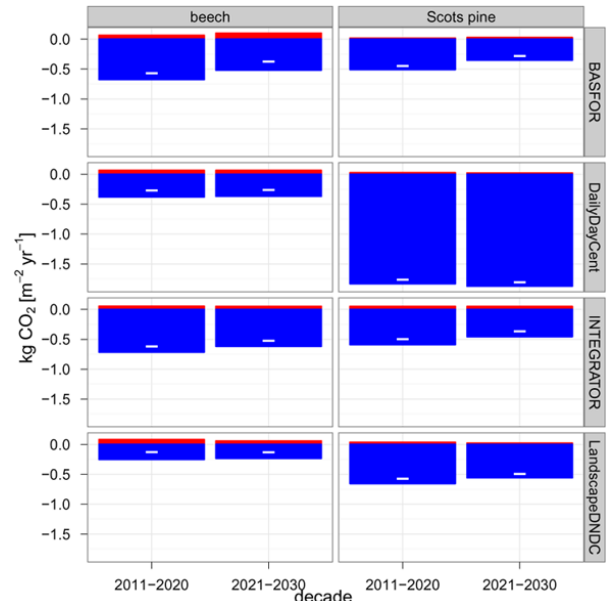
Fig. 1. European average greenhouse gas balance for two dominant forest species (Scots pine and beech) for decades (1) 2011–2020 and (2) 2021–2030. Positive is a source and negative a sink. N 2 O has been scaled with a greenhouse gas warming potential (GWP) of 310 and is in red. CO 2 is in